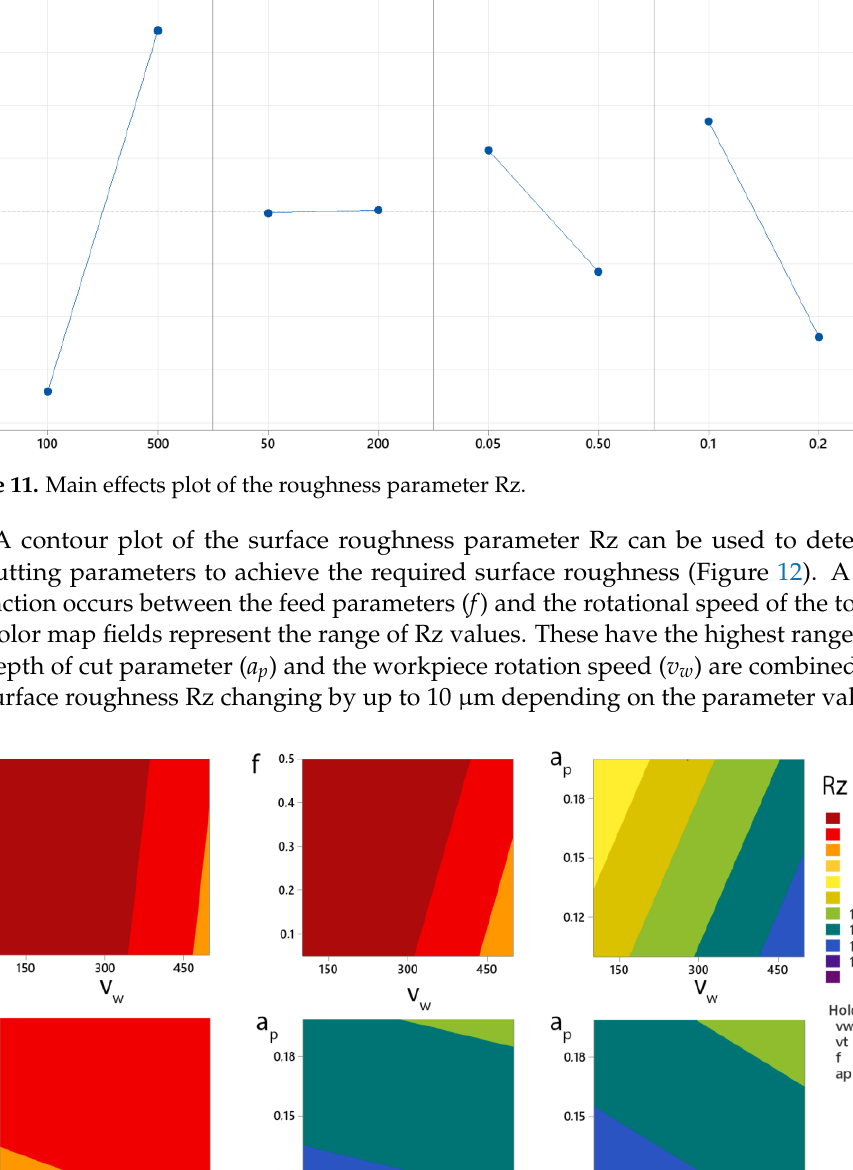
Figure 10. Values of the roughness parameter of the machined surface Rz.